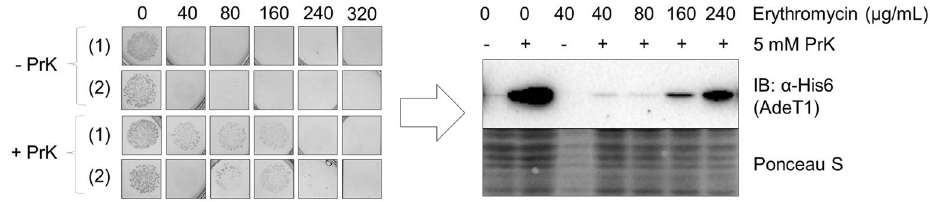
Figure 9. Antibiotic susceptibility of E. coli BL21(DE3) carrying pET28a AdeT1*(K280TAG)-His6 expressed either with or without propionyl lysine (PrK). Data of two biological replicates/independent transformations, (1) and (2), are shown. E. coli BL21(DE3) carrying pET28a AdeT1*(K280TAG)-His6 were cultured to OD 600 0.6 before induction with 0.5 mM IPTG and supplementation with 5 mM PrK (as appropriate). After 2 h, a defined amount of cells were dropped on agar plates containing 0.5 mM IPTG, 5 mM PrK, 100 µg/mL spectinomycin, 50 µg/mL kanamycin and varying concentrations of erythromycin. Plates were incubated at 37 °C for 18 h before colonies were analysed by immunoblotting to confirm protein expression. Full length blots are shown in Supplementary Fig.